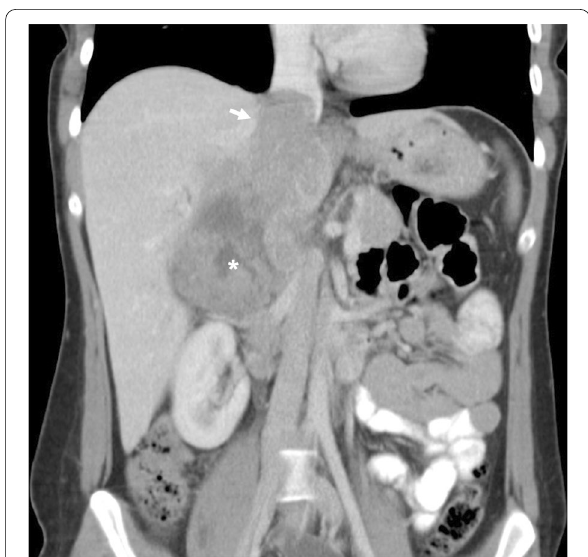
Fig. 19 Adrenal cortical carcinoma invading IVC. Portal venous CT coronal image demonstrates a large adrenal cortical carcinoma (asterisk) with irregular margins, areas of necrosis and invasion of the IVC (arrow)